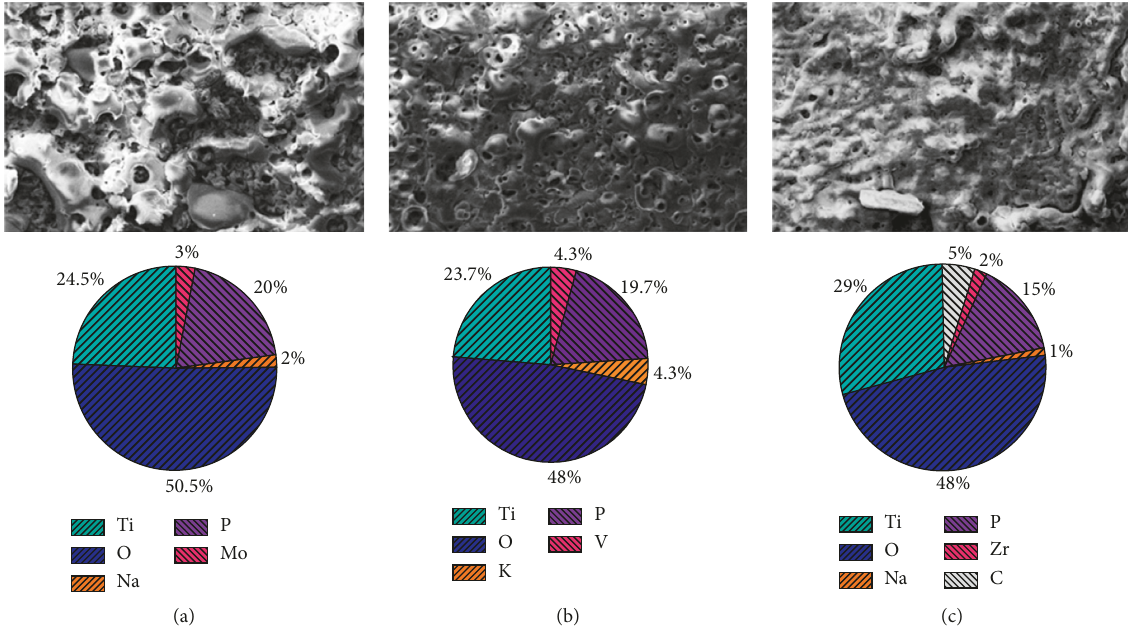
Figure 3: Surface microphotographs (magnification V 2 O 5 ; (c) TiO x ZrO 2 (b) TiO x · ·